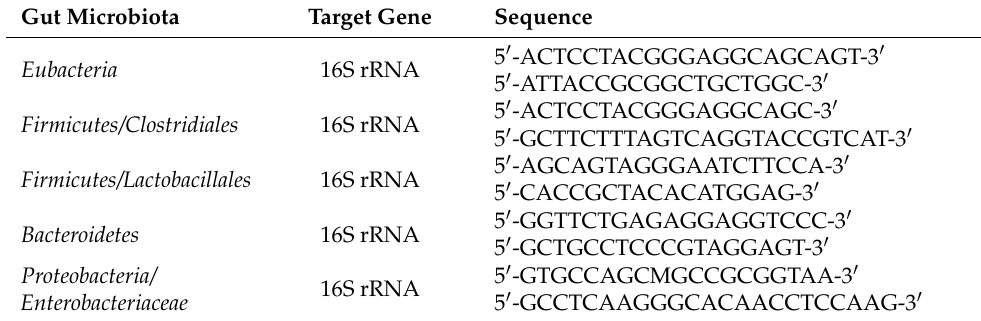
Table 1. Primers using in real-time qPCR [19].